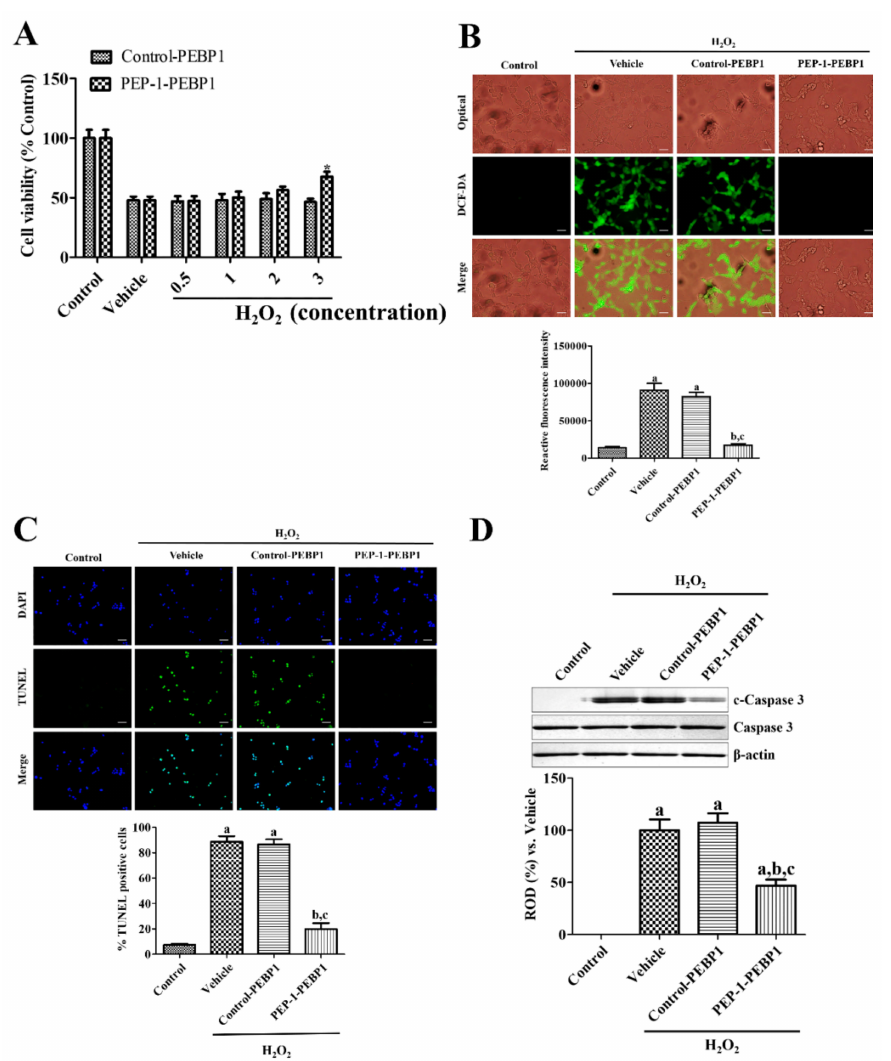
Figure 3. Protective e ff ects of PEP-1-PEBP1 and control-PEBP1 proteins on oxidative damage induced by 1 mM H 2 O 2 treatment in NSC34 cells. ( A ) ELISA assay results for dose-dependent (0.5–3 µ M) viability of NSC34 cells analyzed by WST-1 assay. ( B ) Immunofluorescent staining for DCF-DA and measurement of ROS production using a fluorescence plate reader. ( C ) Immunofluorescent staining for TUNEL and quantitative analysis of TNINEL positive cells by cell counting under a phase-contrast microscopy. Scale bar = 50 µ m (B and C). ( D ) Western blot analysis for caspase 3 and cleaved caspase 3 (c-caspase 3) in the NSC34 lysates. Data were analyzed by Student t -test (* p < 0.05, significantly di ff erent from the control-PEBP1-treated group) or one-way analysis of variance followed by a Bonferroni’s post-hoc test ( a p < 0.05, significantly di ff erent from the control group; b p < 0.05, significantly di ff erent from the vehicle-treated group; c p < 0.05, significantly di ff erent from the control-PEBP1-treated group). The bars indicate mean ±